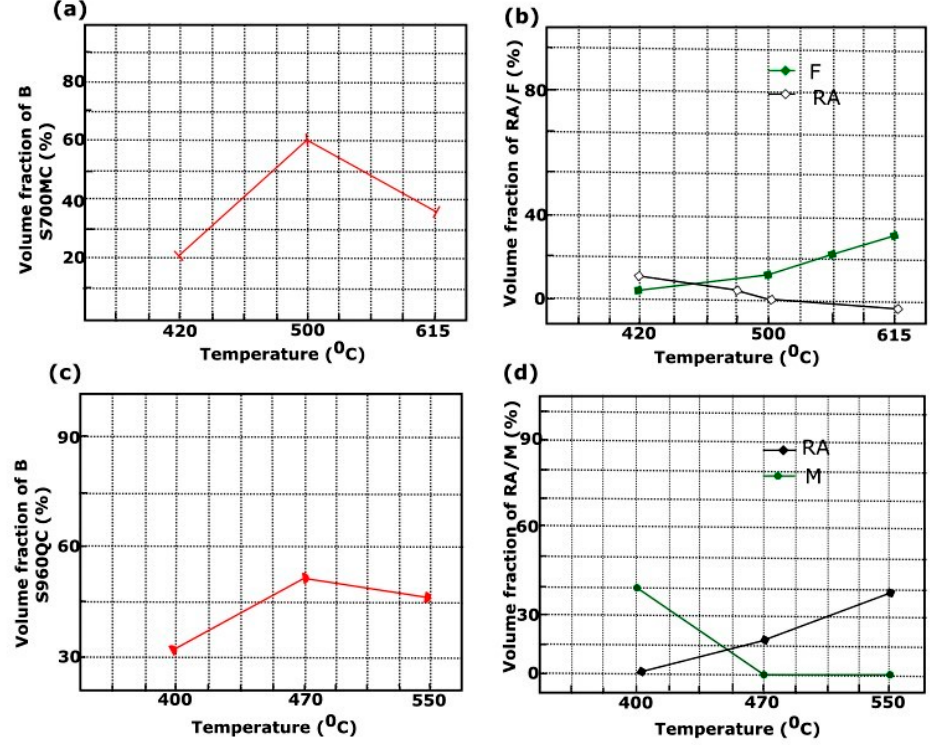
Figure 11. Volume fraction of B, F, and M for both materials: ( a ) volume fraction of B of S700MC, ( b ) volume fraction of RA and F of S700MC, ( c ) volume fraction of B of S960QC, and ( d ) volume fraction of M of S960QC.